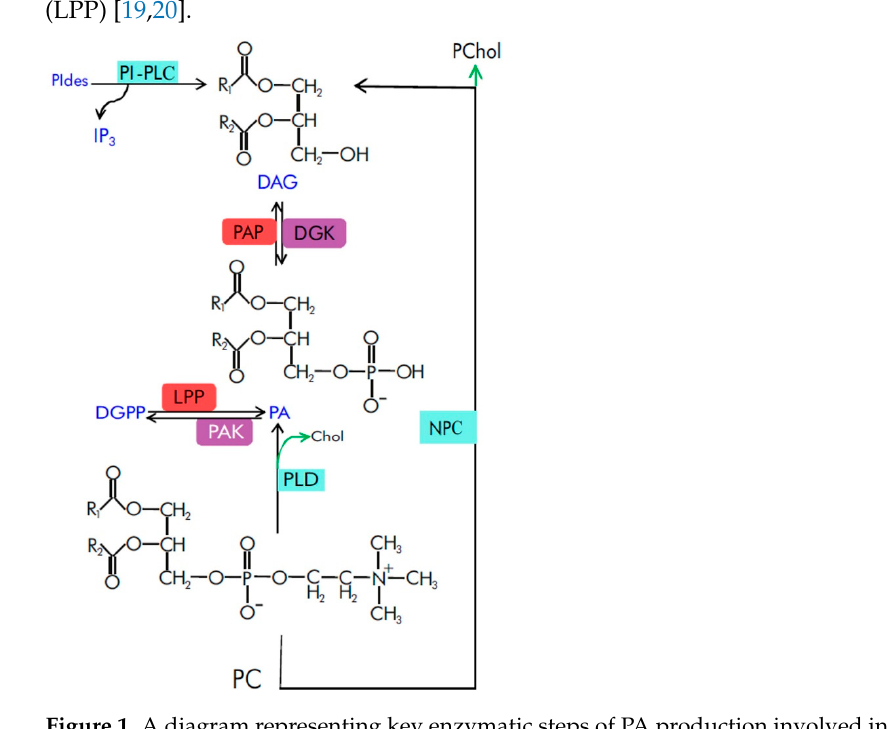
Figure 1. A diagram representing key enzymatic steps of PA production involved in cell signaling. Phosphatidylcholine (PC) is shown as the principal substrate for PLD-generated PA. Signaling lipid mediators and their active products are highlighted in dark blue. Their non-signaling by-products or lipid precursors are shown in black. Phospholipases involved in DAG and PA metabolism are shown in light blue rectangles. Lipid kinases that phosphorylate DAG and PA are shown in violet rectangles. Lipid phosphatases that dephosphorylate DGPP and PA are shown in light red rectangles. Black arrows indicate pathways that generate signaling lipids; green arrows indicate pathways that generate by-products. Note that no PAK-coding gene is currently identified in Arabidopsis . Chol, choline; DGK, diacylglycerol kinase; DGPP, diacylglycerol pyrophosphate; IP 3 , inositol 1,4,5-trisphosphate; LPP, lipid phosphate phosphatase; NPC, nonspecific phospholipase C; PAK, phosphatidic acid kinase; PAP, phosphatidic acid phosphatase; PChol, phosphocholine; PC, phosphatidylcholine; PIdes, phosphoinositides, PI-PLC, phosphatidylinositol-specific phospholipase C; PLD, phospholipase D; R 1 , R 2 , fatty acids.